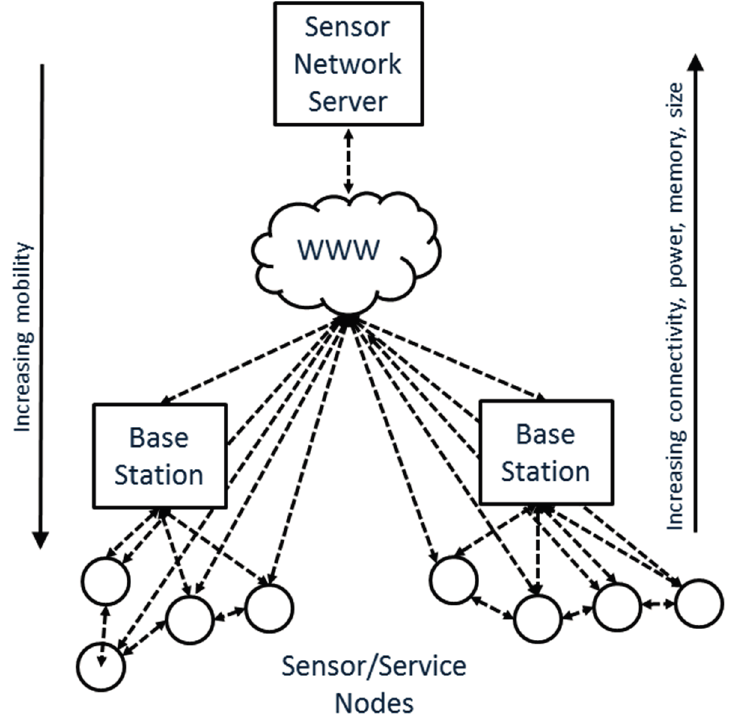
Figure 3. Distributed SOA architecture with on-board discovery, serving and sensing